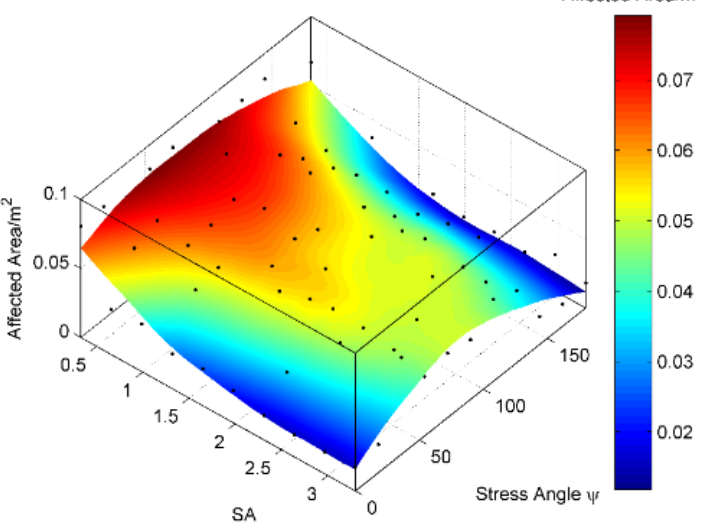
Figure 14. The variation of affected area with ψ and SA. The result of each simulation is represented by a black point. The smoothed value is represented by the colored